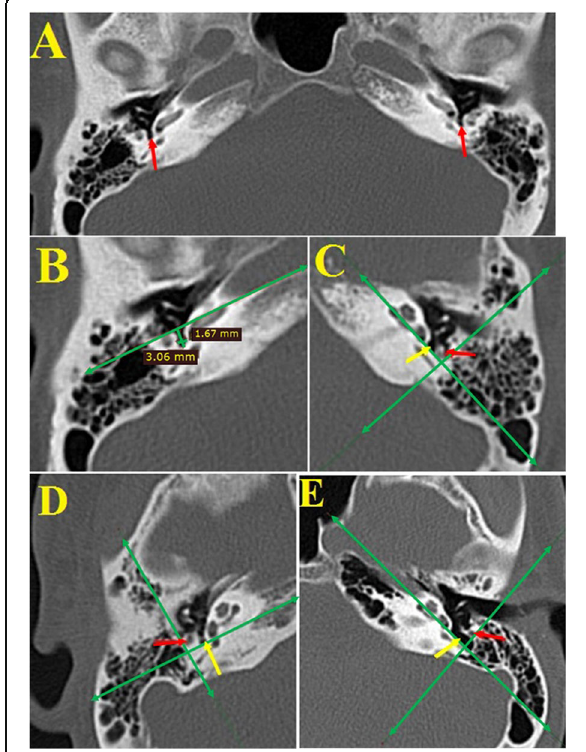
Fig. 4 Sinus tympani (ST) (STR) measurements and types. a Axial CT images showing the right and left Sinus tympani (ST) (red arrows). b Measurement of right ST length and width (ST-L & ST-W) in axial CT image. c – e Different types of ST; yellow arrow points to ST and red arrow points to the facial nerve. The green lines passing through the floor of the ST and the outer wall of the facial nerve canal demonstrate the relation between ST and facial